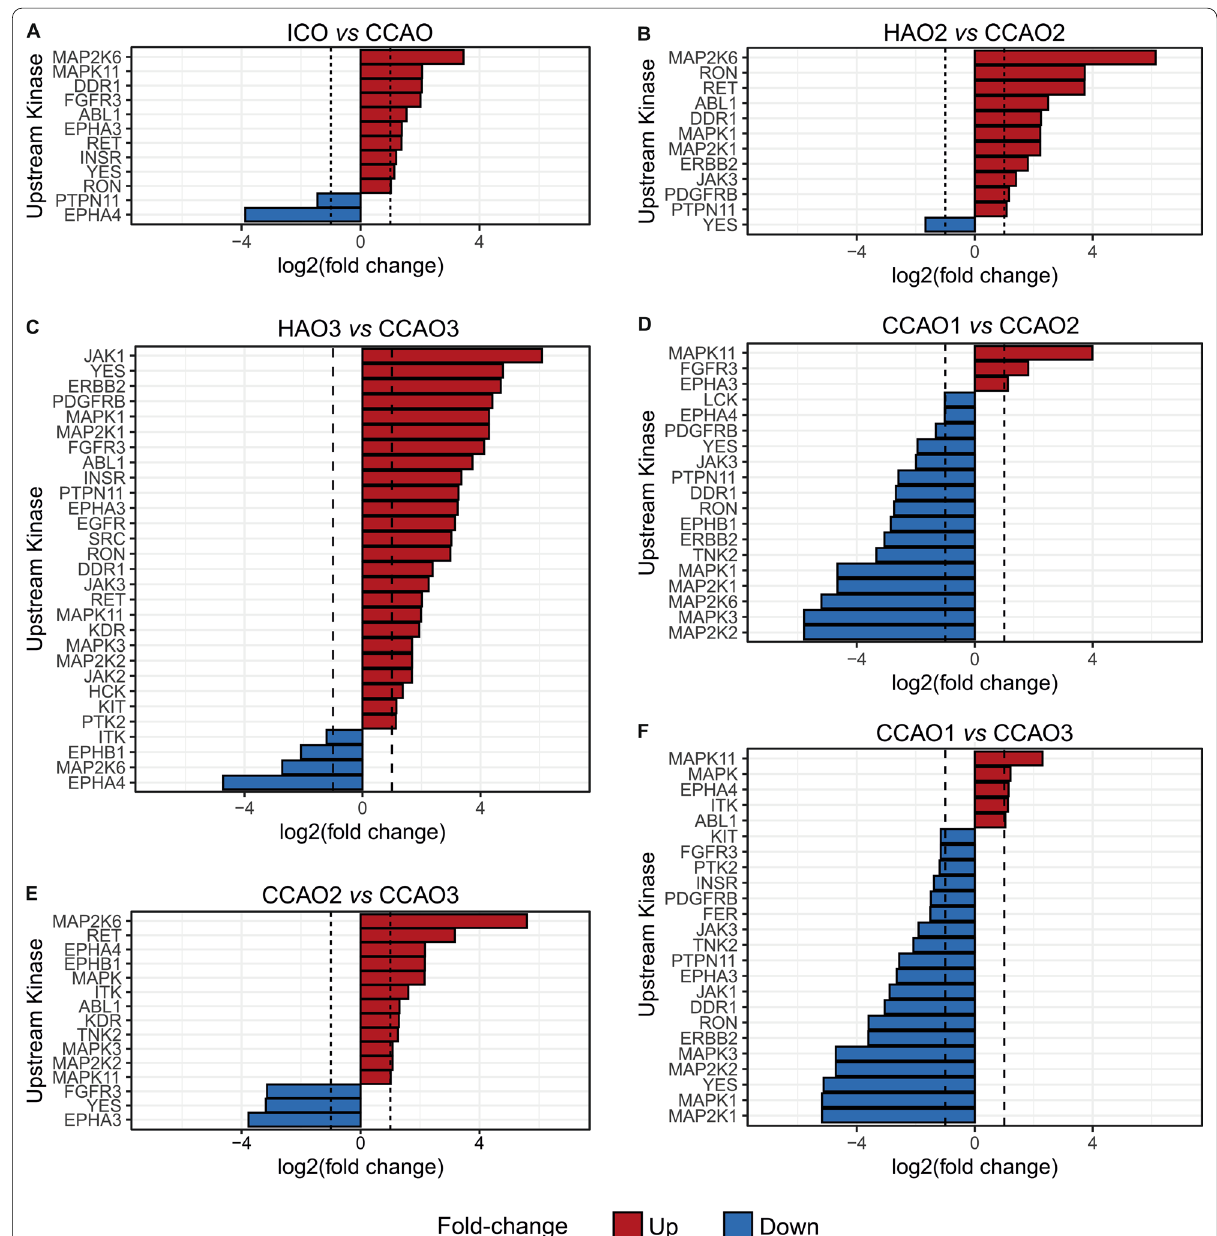
Fig. 3 CCAOs demonstrate activity of diverse kinase pathways. Bar graphs displaying upstream kinases that have an average fold change > 2. A ICO (blue higher activity) vs CCAO (red higher activity). B HAO2 (blue higher activity) vs CCAO2 (red higher activity). C HAO3 (blue higher = = = = = activity) vs CCAO3 (red higher activity). D CCAO2 (blue higher activity) vs CCAO1 (red higher activity). E CCAO3 (blue higher activity) vs = = = = CCAO2 (red higher activity). F CCAO3 (blue higher activity) vs CCAO1 (red higher = = =